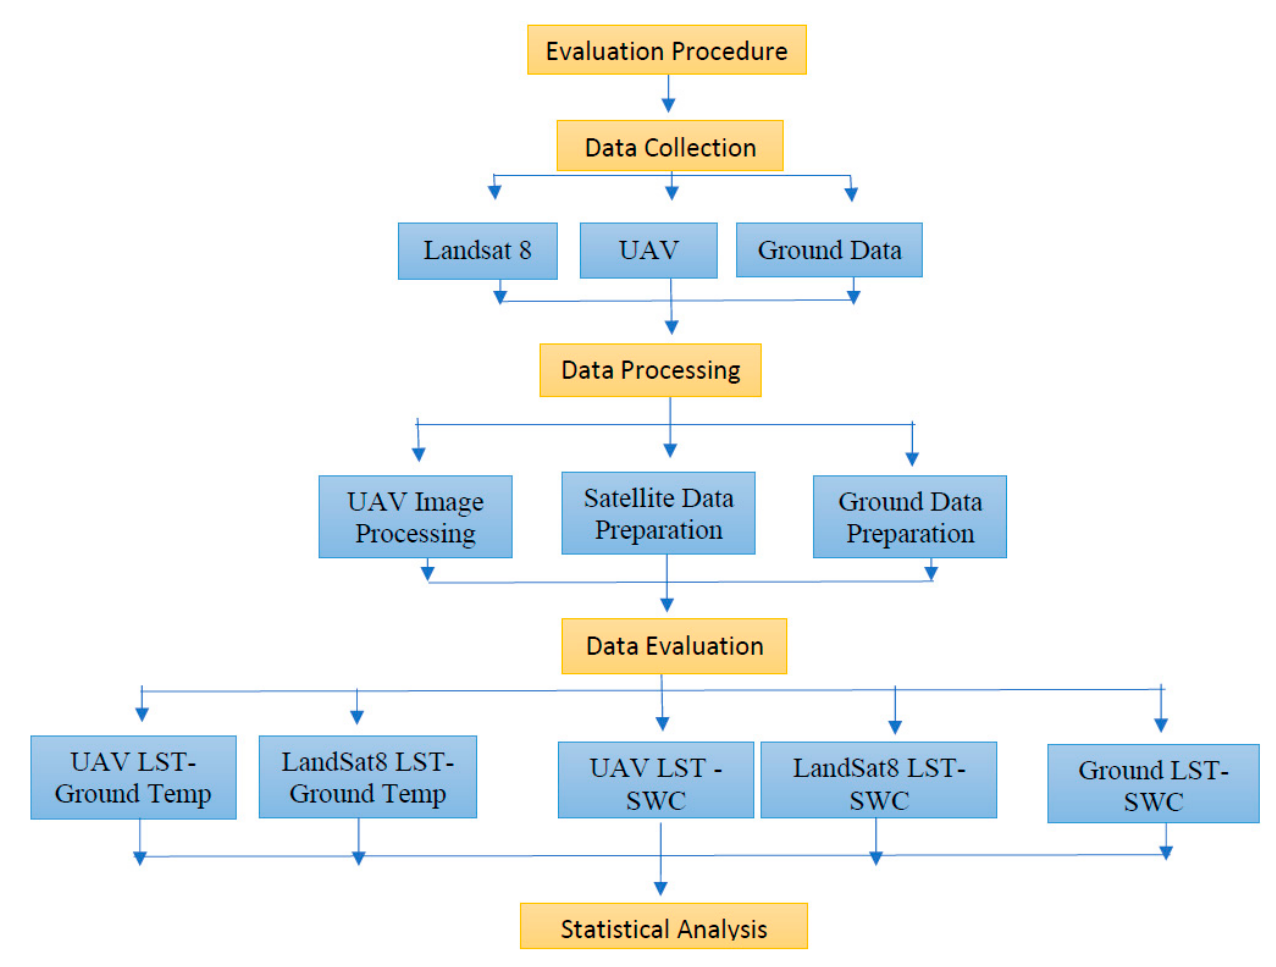
Figure 3. Flow chart of the evaluation procedure.